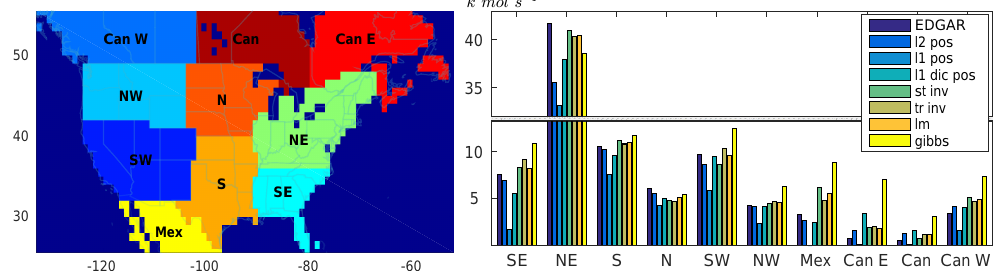
Figure 10. Regional EDGAR emissions and emission estimates for the methods studied in Miller et al. (2014) and the Tikhonov reconstruc- tion methods studied